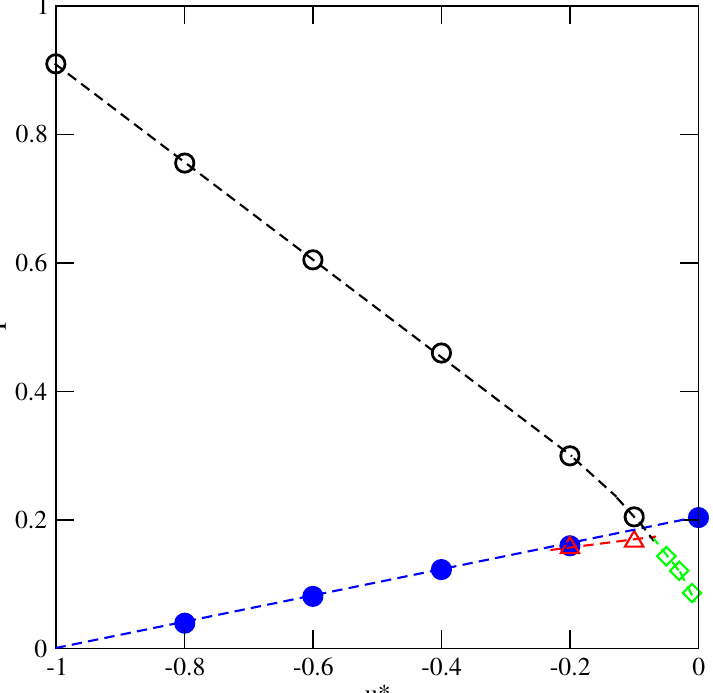
Figure 3. The changes of the critical temperature, T c ( u ∗ ) , (circles), the critical end point temperature, T cep ( u ∗ ) , (triangles) the orientational order − disorder transition temperature in close-packed systems, T o ( u ∗ ) (filled circles), and the tricritical point temperatures, T trc ( u ∗ ) (triangles), with u ∗